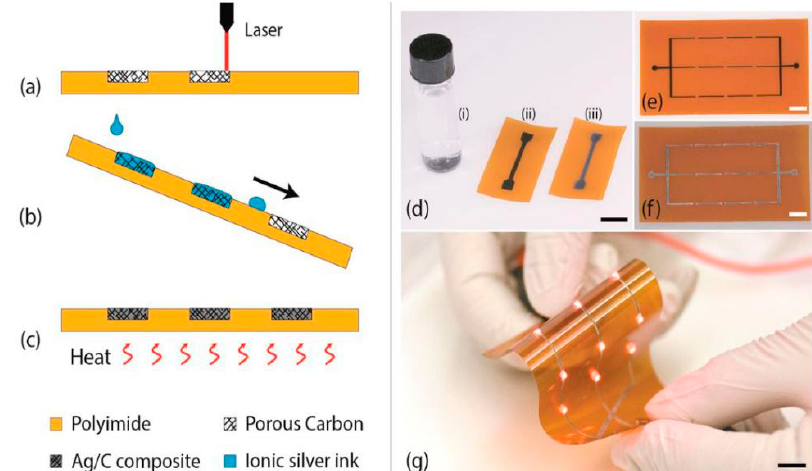
Figure 4. ( a – c ) Schematic diagram of the fabrication steps using laser pyrolysis, ( d ) laser-carbonized traces prior to and after the coating with silver nanoparticles, ( g ) experimentation with an array of LEDs. Reproduced from Rahimi, R., Ochoa, M. and Ziaie, B., 2016. Direct laser writing of porous- carbon/silver nanocomposite for flexible electronics. ACS applied materials & interfaces , 8 (26), pp.16907- 16913 [27] .